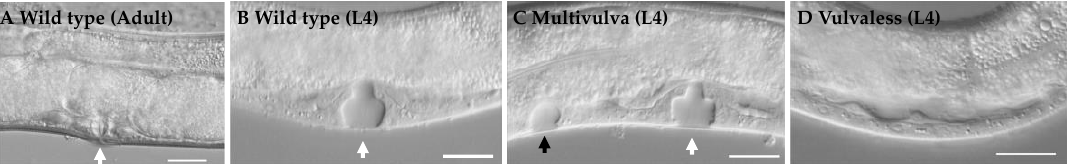
Figure 1. Images of wild type and mutant vulvae at adult or L4 stage. ( A – D ) White and black arrows indicate normal and ectopic pseudovulvae, respectively. (scale bar = 10 µ m in ( A ) and 20 µ m in ( B – D )) ( A ) Vulva in wild type (N2) adult. ( B ) Vulva in wild type (N2) L4 stage. ( C ) Multivulva phenotype in let-60 ( n1046 gf). ( D ) Vulvaless phenotype in lin-12 ( n379 d).